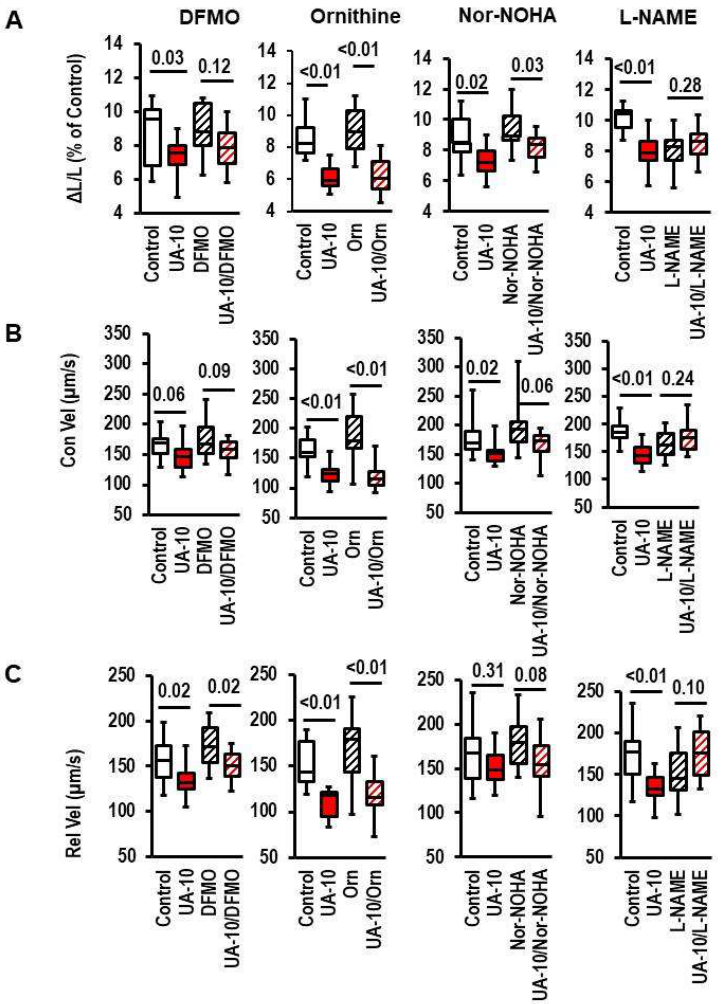
Figure 3. Effect of difluoromethyl ornithine (DFMO), ornithine (Orn), N ω -Hydoxy-l-arginine-ace- tate (Nor-NOHA), or L-N G -Nitro arginine methyl ester (L-NAME) on cell shortening and uric-acid (UA)-dependent effects. Data show the effects on cell shortening (( A ) ; ΔL/L), contraction velocity (( B ); Con Vel), and relaxation velocity (( C ); Rel-Vel). Data are expressed as bars and whiskers with median, 25% quartile, 75% quartile indicated by bars, and complete range by whiskers. Statistical analysis is based on Student t -tests and exact p -values are indicated. Data are means from n = 10 (each) preparations (rats), with 4 cell culture dish per preparation and 9 cells evaluated per cell- culture dish. Statistical analysis is based on preparations. Two-way ANOVA was performed to ex- clude an interaction between the UA effects and that of the inhibitors. 3.3. Effect of Extracellular Arginine on UA Effects The data of the aforementioned experiments support the idea that UA induces an arginine depletion. This may induce a limitation of intracellular arginine bioavailability required for proper function. This hypothesis was tested by increasing the concentration of l-arginine in the medium in the copresence of UA. Increasing the l-arginine concentra- tion, the natural substrate for NOS, attenuated the effect of UA in a concentration-depend- ent way (Figure 4A,B). However, when l-arginine was replaced by d-arginine, the